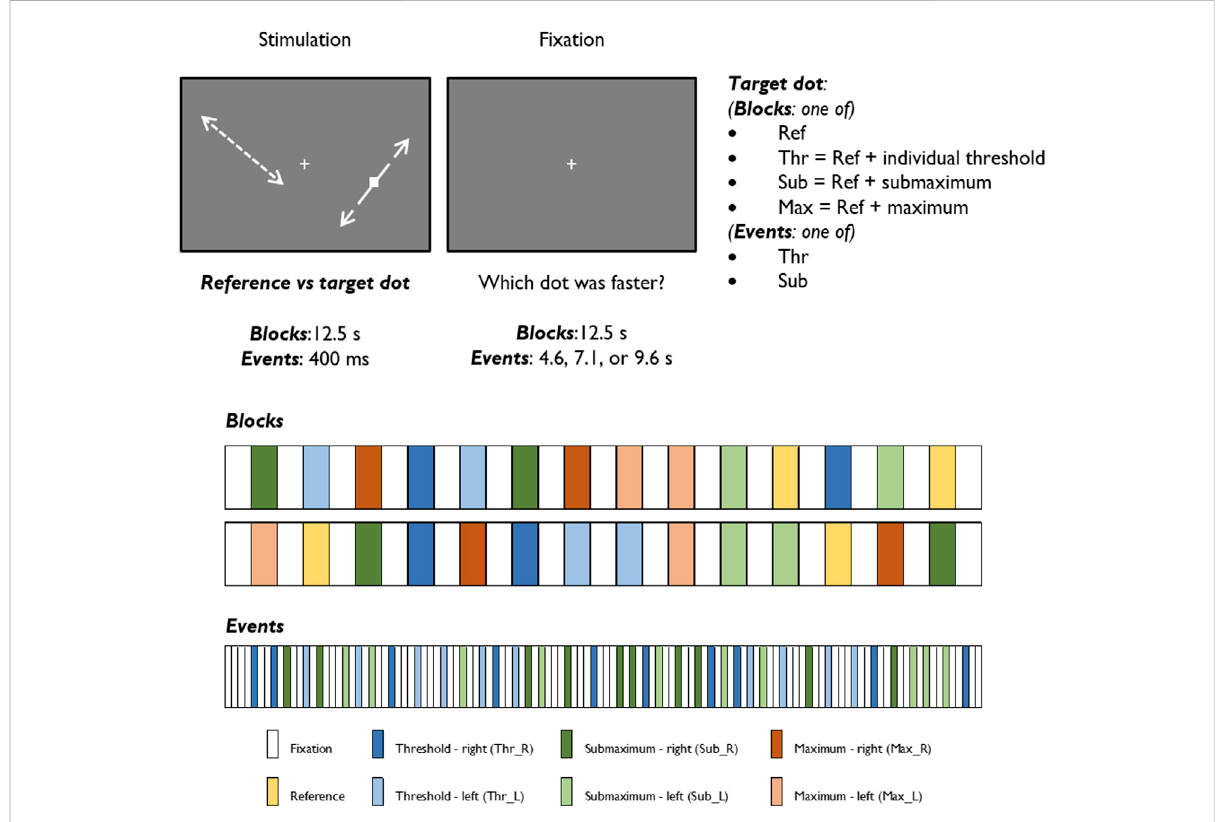
FIGURE 1 Graphical representation of the stimuli and experimental protocols of block and event-related